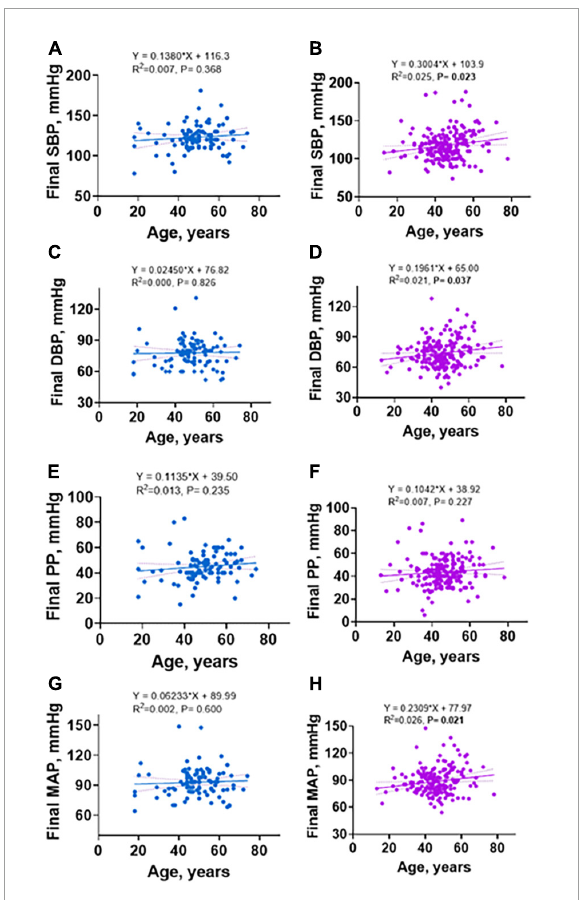
FIGURE4 Linear regression of sex differences in relationship between age and final SBP, DBP, PP, and MAP. (A) SBP in males, (B) SBP in females, (C) DBP in males, (D) DBP in females, (E) PP in males, (F) PP in females, (G) MAP in males, (H) MAP in females.